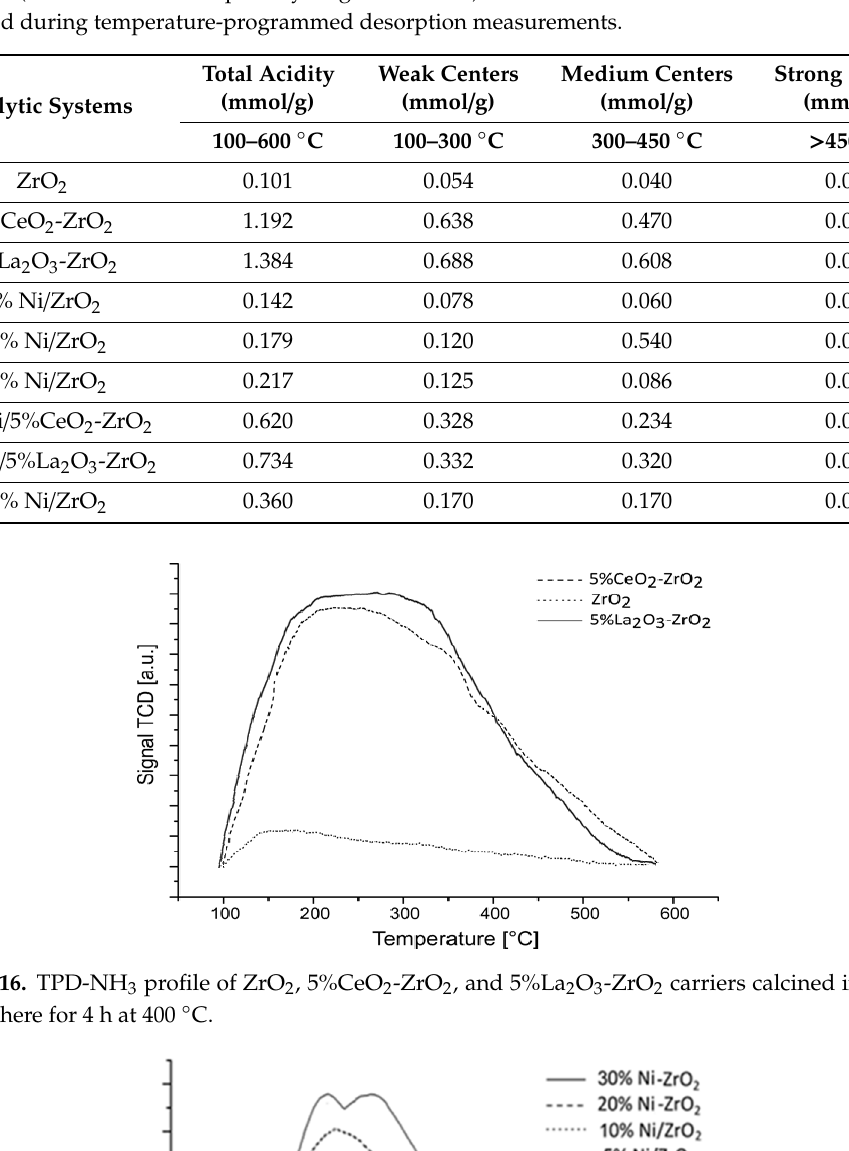
Figure 18. TPD-NH 3 profile of 20%Ni/ZrO 2 , 20%Ni/5%CeO 2 -ZrO 2 , and 20%Ni/5%La 2 O 3 -ZrO 2 catalysts reduced in hydrogen for 1h at 500 °C.